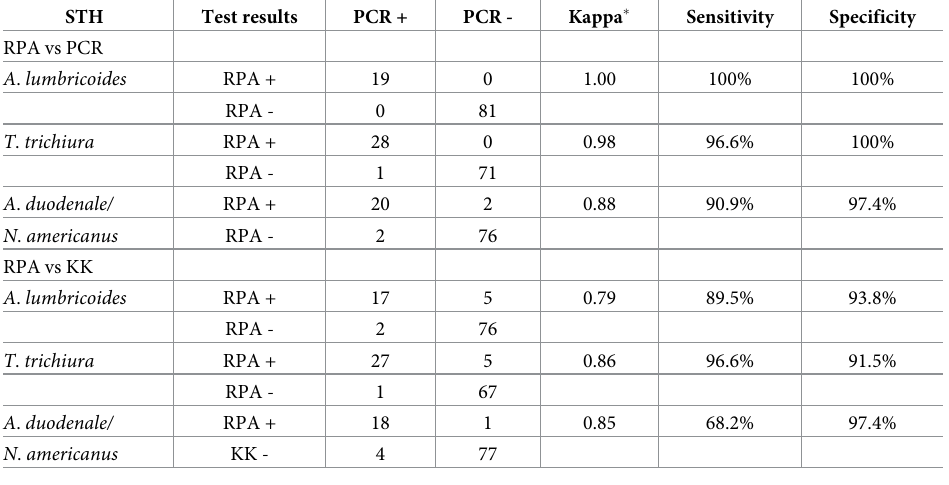
77 � The agreement between the diagnostic methods was assessed using κ -statistics. The κ -statistics were interpreted as < 0.20, poor agreement; 0.21–0.40, fair agreement; 0.41–0.60, moderate agreement; 0.61–0.80, good or substantial agreement; 0.81–1.00, very good or almost perfect agreement.